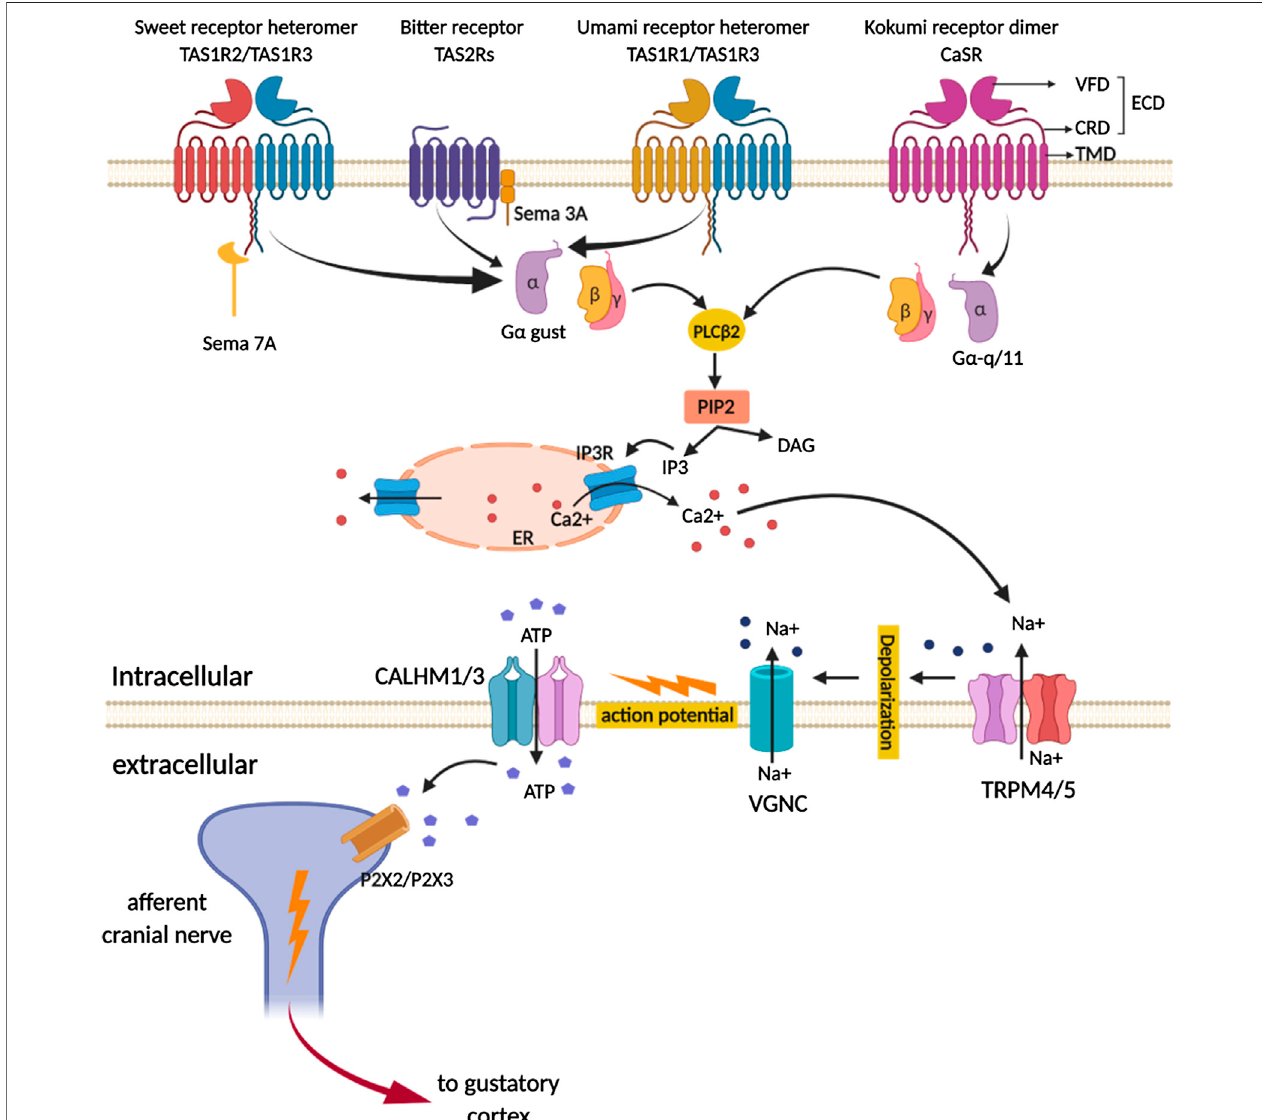
FIGURE3| Schematic representation ofsignal transductionpathway ofsweet, umami, bitterand kokumi-calcium sensingreceptors (CaSR) intaste receptor cells on the tongue. Ligand-induced stimulation of the sweet (TAS1R2/TAS1R3), umami (TAS1R1/TAS1R3), bitter receptors (TAS2Rs) and kokumi sensation expressed in type II taste cells within taste bud activates a trimeric G protein composed of α -gustducin (G α -gust) in sweet, umami, bitter and G α -q/11 in kokumi-receptor and a complex consisting of G β γ proteins. The released G β γ -complex activates phospholipase C isoform β 2 (PLC β 2) which then induces production of inositol 1,4,5- trisphosphate (IP3) and diacylglycerol (DAG); the second messenger IP3, in turn activates the IP3 receptor (IP3R), an intracellular ion channel that allows Ca 2+ release fromtheintracellularendoplasmicreticulum(ERstore).IncreaseinintracellularCa 2+ thenactivatesthecomplexoftransientreceptorpotentialcationchannelsubfamilyM member 4 and 5 (TRPM4/5) that are plasma membrane localized sodium-selective channels which leads to depolarization and subsequent activation of voltage-gated sodium channels (VGSC). The combined action of increased Ca 2+ and membrane depolarization activates the complex of calcium homeostasis modulator 1 and 3(CALHM1/3) channel and pannexin1 channels, thus resulting in the release of the neurotransmitter ATP. Increased ATP, in turn activates P2X ionotropic purinergic receptors 2and 3(P2X2/P2X3) onafferent cranialnervegeneratingan action potential thatsubsequently signals tothegustatory cortex for sensory perception.Besides well-known tasteGPCRpathways, connectingproteins semaphorin 7A(Sem 7A)and 3A(Sem 3A) aredepictedinclose contact with sweetand bitterreceptors asthey provide instructive signals that fi ne tune to sweet or bitter ganglion neurons, respectively. VFT, venus fl ytrap domain; CRD, cystine rich domain; ECD, extracellular domain. (created with